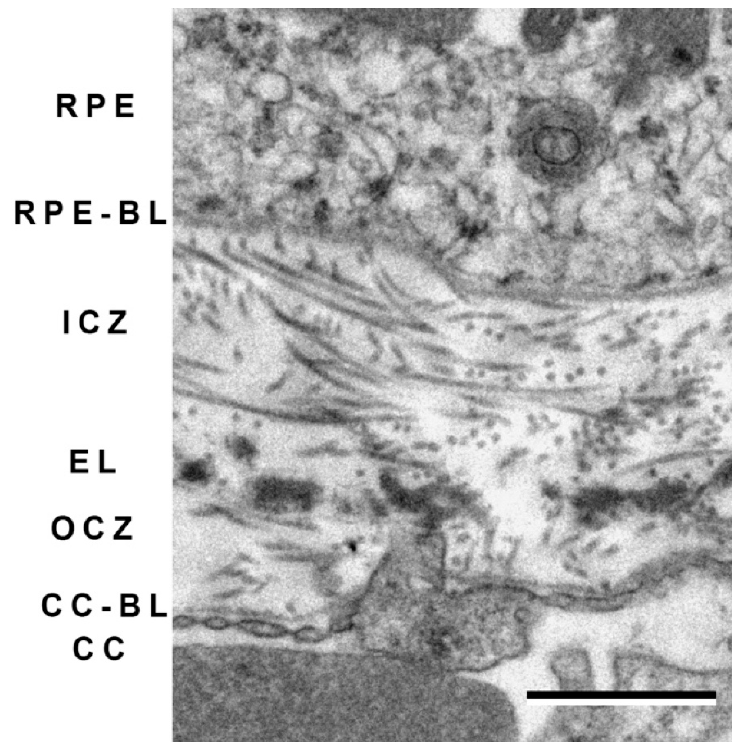
Figure 11. Transmission electron micrograph depicting the layers of Bruch’s membrane from a human eye. Both the basal laminae of the RPE and choriocapillaris (RPE-BL and CC-BL) are depicted, in addition to inner collagenous zone (ICZ) and outer collagenous zone (OCZ), occupied by fibrillar collagens, as well as the elastic lamina (EL), evident by its thick electron dense bundles. Scale bar = 1 μ m.